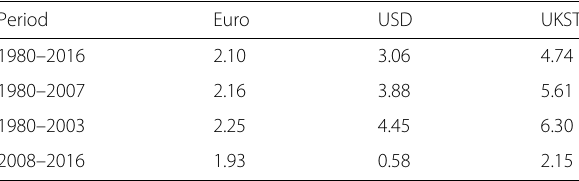
and equity (next section) portfolios. The long-lived devi- ations from uncovered interest parity displayed in the last section are sure to have some influence on the longer maturity assets but differences in the dynamics of term premia and inflation risk premia across currencies are also plausible. This is notably the case because of the well-known link between inflation levels and volatility